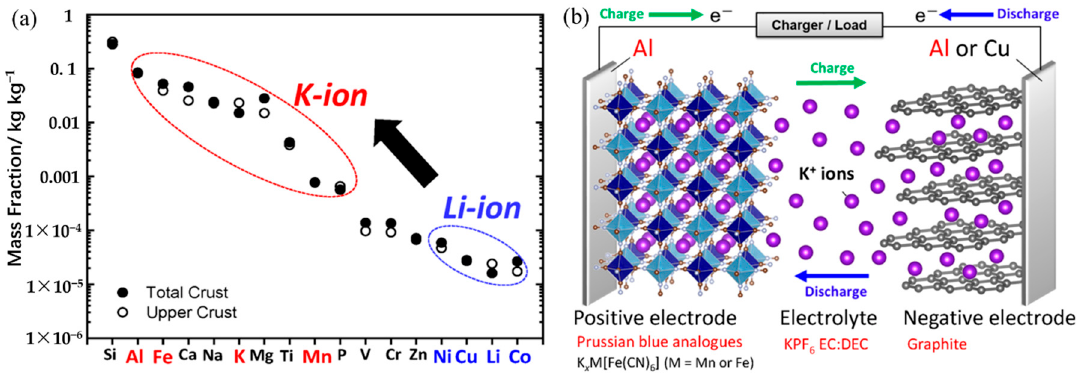
Figure 1. ( a ) Elemental abundance in the Earth’s crust. ( b ) Schematic illustration of the cell configuration and operational mechanism of a typical K-ion battery. ( a , b ) Reproduced with permission from Ref. [7]. Copyright 2020 American Chemical Society.